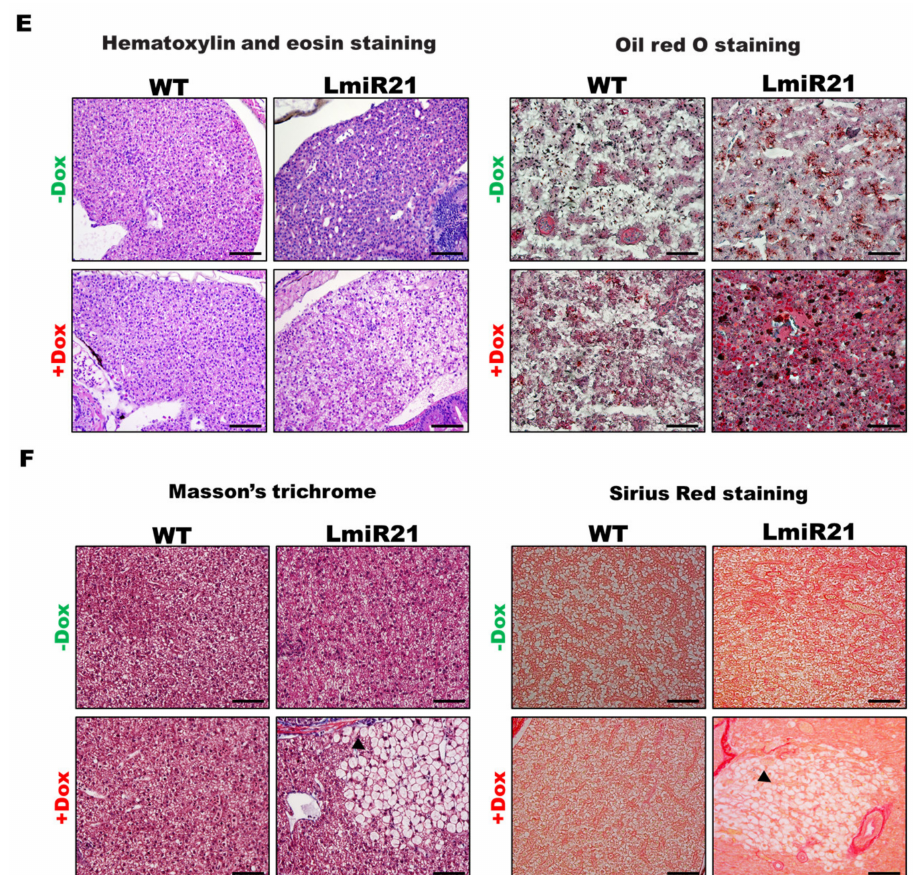
Figure 2. Characterization of hepatic steatosis in LmiR21 larvae and adult. ( A ) Whole-mount oil- red O (ORO) staining of WT ± Dox and LmiR21 ± Dox larvae at 21 dpf. Lipid contents in livers and swim bladders were stained by ORO (up). Scale bar: 2 mm. Percentages of WT ± Dox and LmiR21 ± Dox larvae with weak, moderate and strong levels of hepatic steatosis at 21 dpf (down). Scale bar: 200 µ m. ( B ) Representative ORO images of liver in 21 dpf larvae (left). Scale bar: 500 µ m. Hematoxylin-eosin (H&E) staining of livers at 21 dpf LmiR21 + Dox larvae show abnormally shaped hepatocytes with lipid vacuoles (arrows) compared with that in the controls at the same stage. Scale bar: 100 µ m. (right). ( C ) Gross liver phenotypes at 4 months post fertilization (mpf) LmiR21 ± Dox. Normal hepatic morphology is clearly composed of lobes in LmiR21 − Dox adult (panels 1,2). Liver hyperplasia with yellow and greasy phenotypes in LmiR21 + Dox adult liver (panels 3,4). Scale bar: 5 mm. ( D ) Triglyceride (TG) and total cholesterol (TC) in the livers is greater in LmiR21 + Dox than in the controls ( n = 3). Statistically significant differences from LmiR21 − Dox were denoted by ** ( p < 0.01). ( E ) H&E staining of liver tissue from WT ± Dox and LmiR21 ± Dox at 4 mpf depicting morphological changes resulting from accumulation of microvesicular steatosis. Scale bar: 50 µ m. (left). ORO staining of liver cryosections from WT ± Dox and LmiR21 ± Dox adults at 4 mpf. Scale bar: 50 µ m. An abundance of lipid accumulation is observed in LmiR21 + Dox compared to that in controls. (right). ( F ) Representative liver sections showing ballooned hepatocytes (large arrow) and lipid vacuoles (star) with Masson’s trichrome (left), and Picrosirius red (right). Scale bar: 50 µ